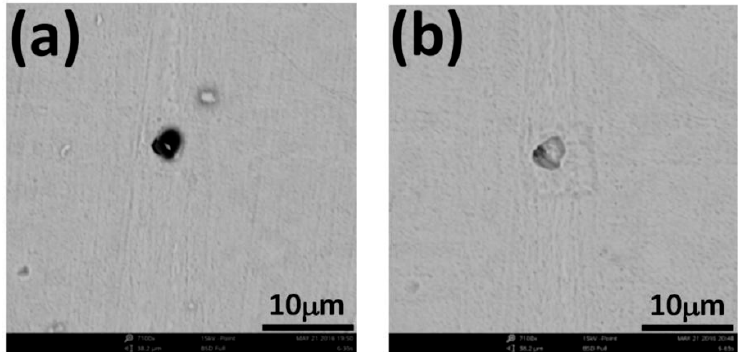
Figure 10. Al 2 O 3 inclusions fall off. ( a ) 35 s; and ( b ) 65 s.